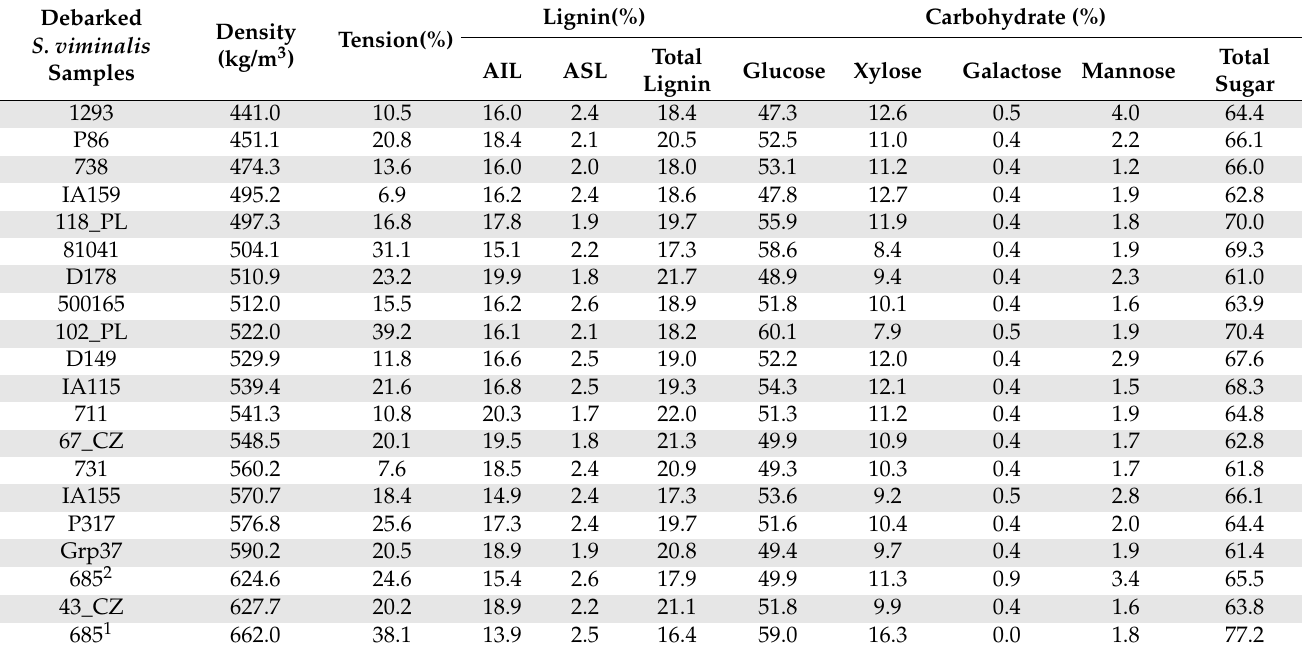
Table 1. Tension (%), density, and chemical analysis of sugars and lignin in selected clone samples. Chemical results reflect the average of 3 technical replicate analyses from 300 mg S. viminalis clone taken from milled 5 cm stem samples. Debarked S.